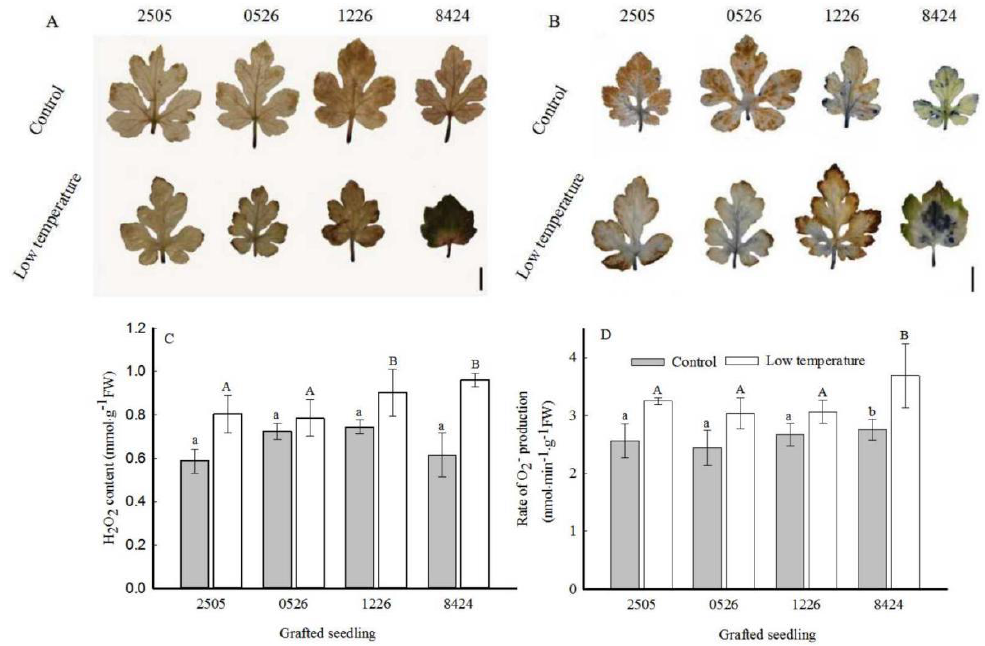
Figure 1. Effects of cold stress on the accumulation of H 2 O 2 ( A ) and O 2 •­ ( B ), as well as the content of H 2 O 2 ( C ) and O 2 •­ producing rate ( D ) in leaves of different watermelon seedlings. The numbers 0526, 2505, and 1226 represent watermelon grafted onto three different gourds, while 8424 means non-grafted watermelon. Scale bars correspond to 2 cm. Data are the mean ± SE. Bars with different letters indicate a significant difference (p < 0.05).